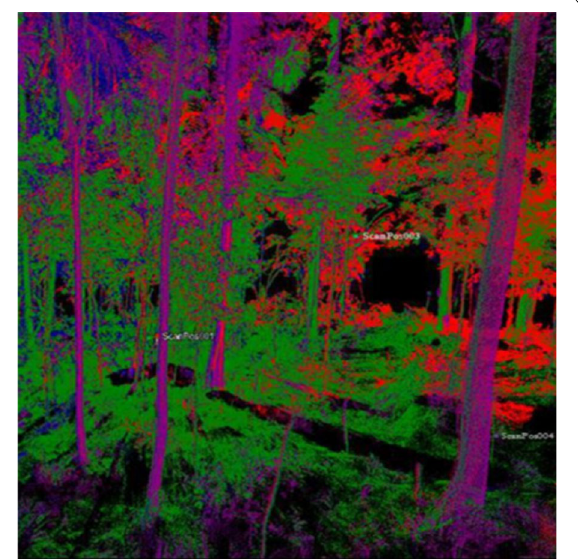
Fig. 4 Sample registered point cloud data displayed in four colors representing four scan